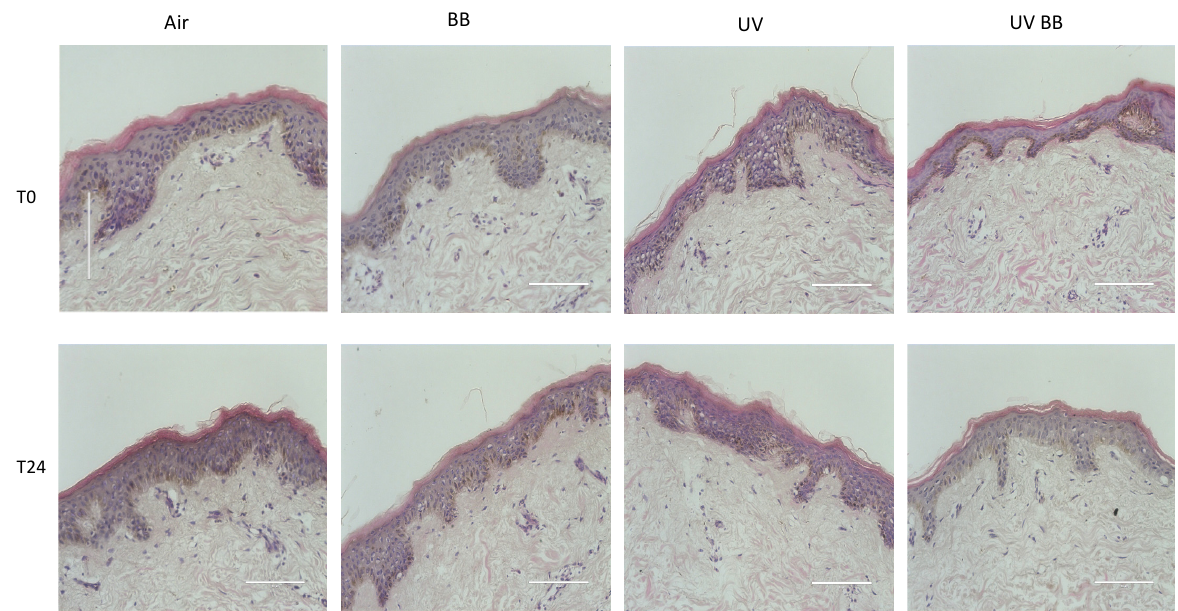
Figure 2. Tissue structure and morphology upon BB pre-treatment and UV exposure. H&E staining of ex vivo human skin explants, untreated or pre-treated with Alaskan blueberry extract (BB) and then exposed to UV light (200 mJ of UVA/UVB). Scale bar 100 µ